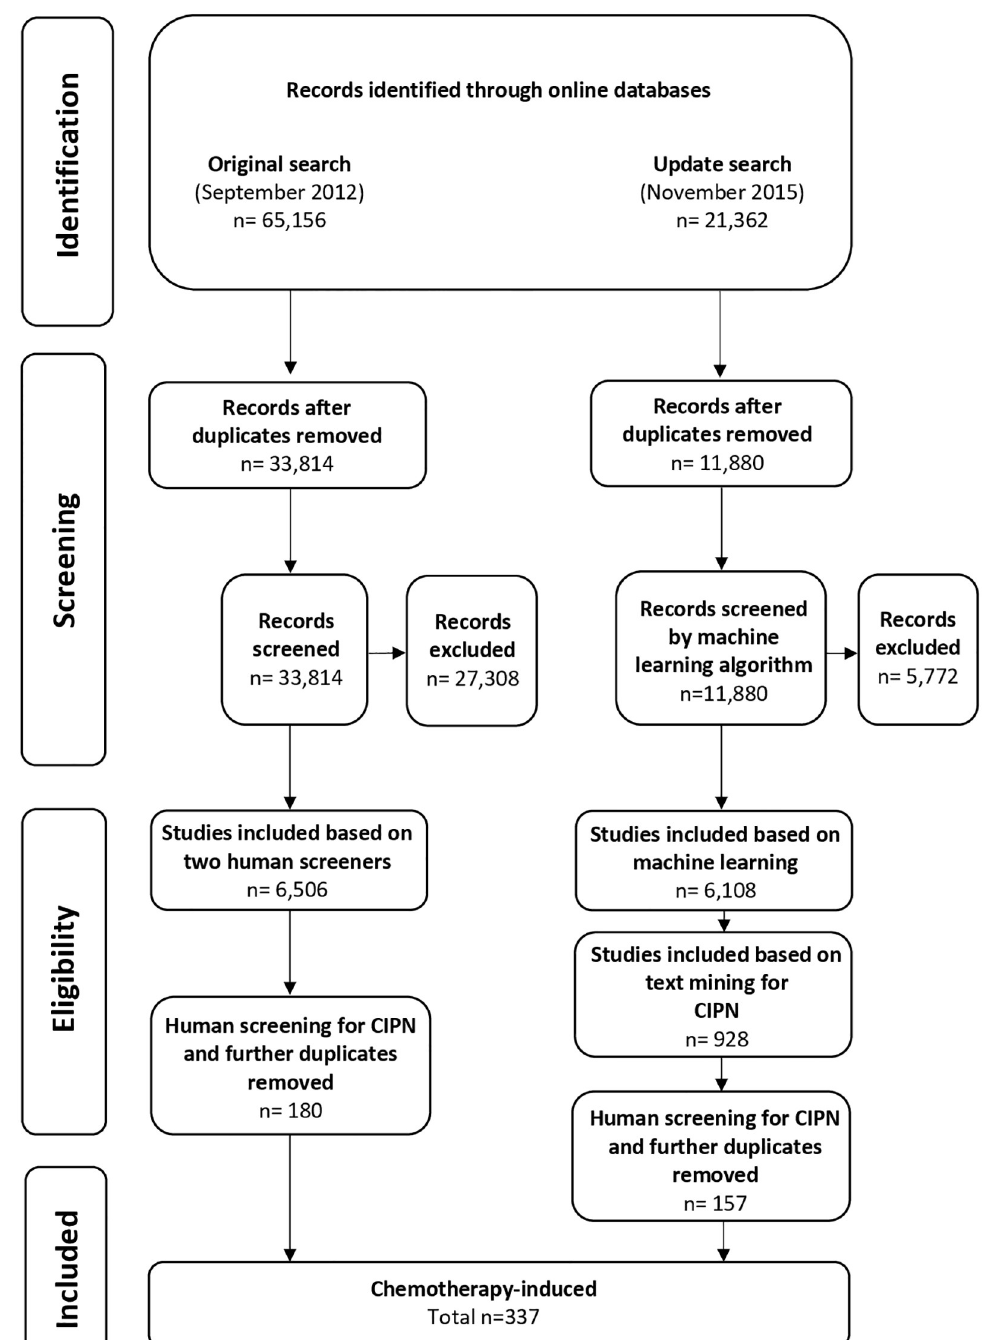
Fig 1. Flow diagram of included studies. CIPN, chemotherapy-induced peripheral